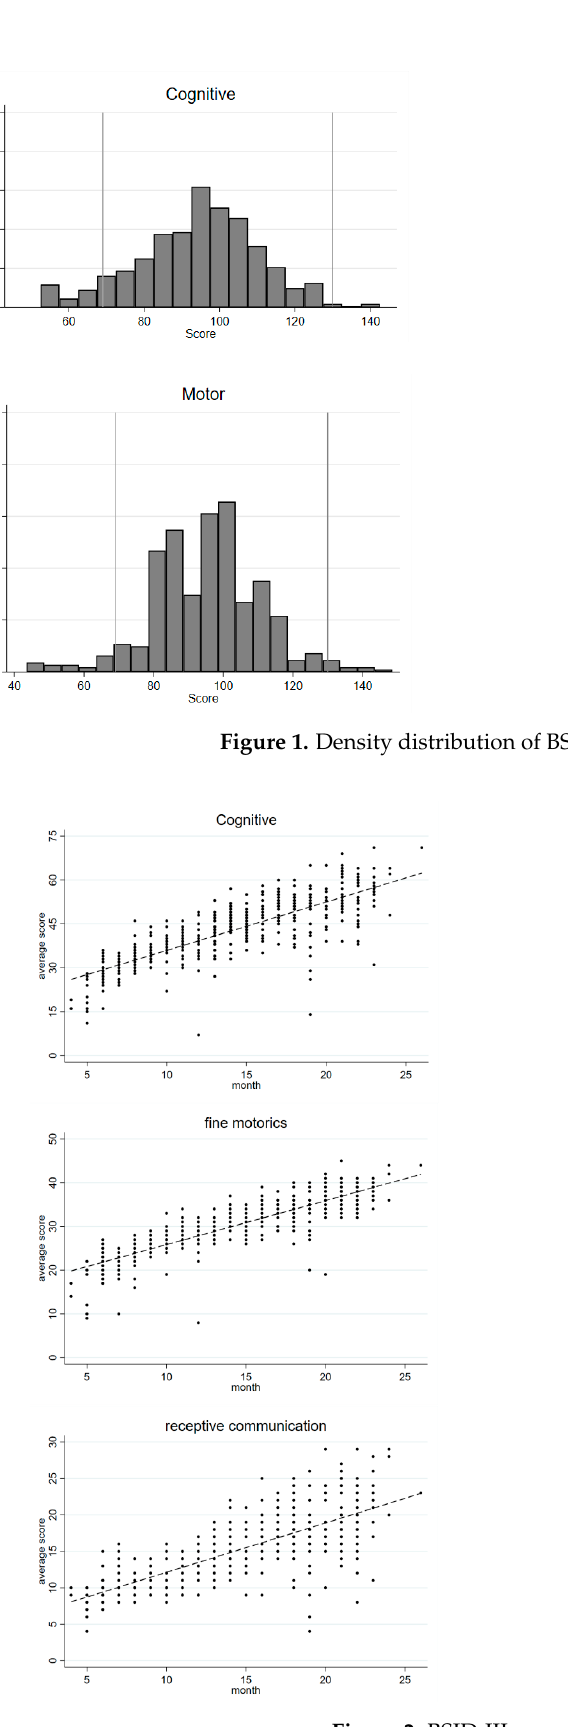
Figure 2. BSID-III raw scores by age.